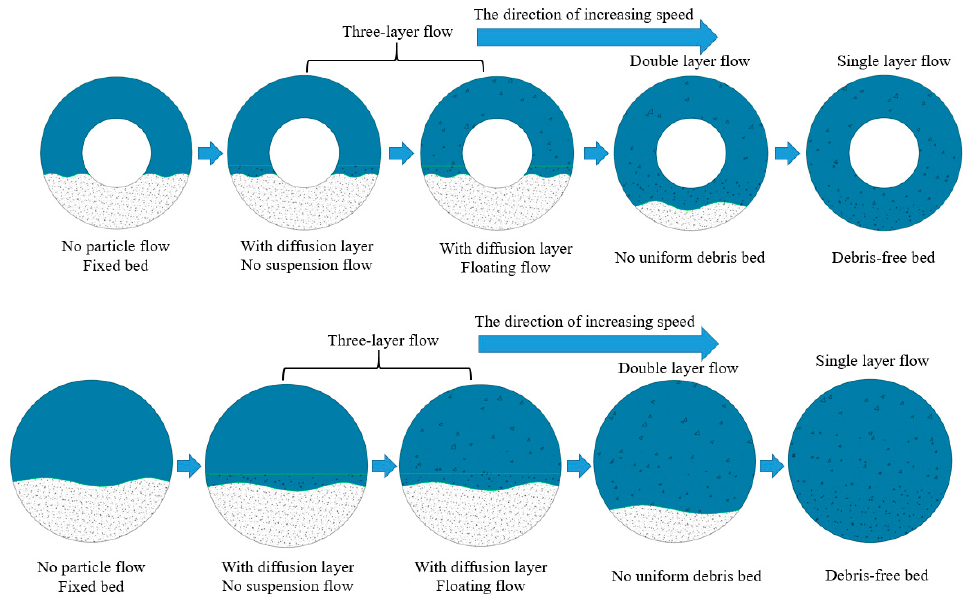
Figure 3. Types of solid particle migration.